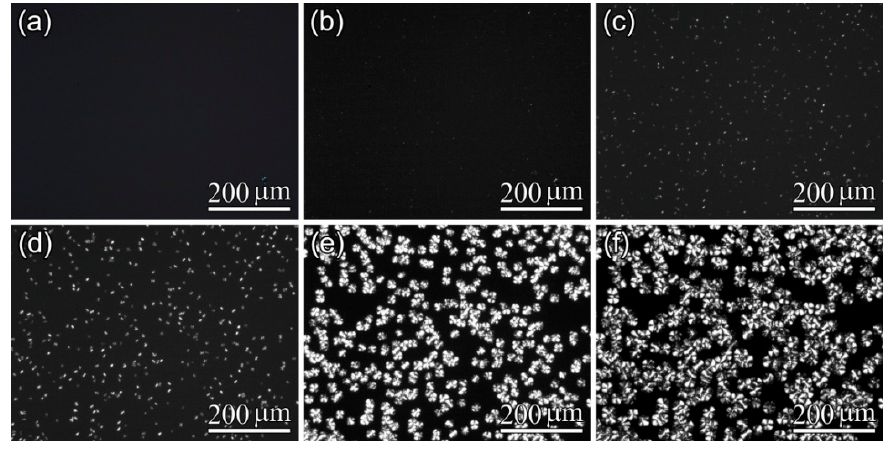
Figure 5. POM micrographs of PLA-U film during isothermal crystallization at 110 °C: ( a ) 0 min; ( b ) 20 min; ( c ) 30 min;( d ) 40 min; ( e ) 90 min; and ( f ) 120 min.